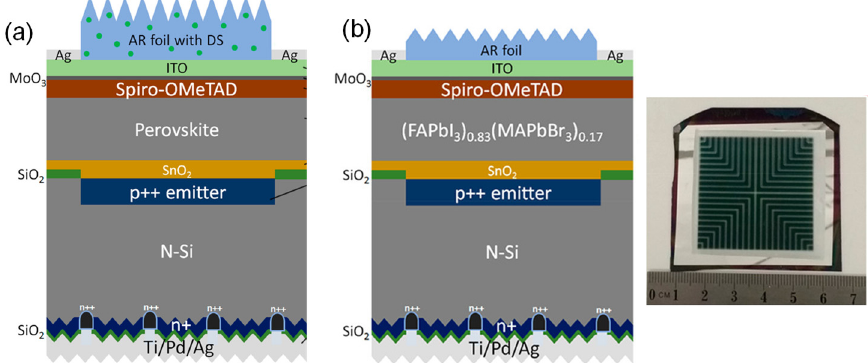
Figure 8. ( a ) Schematic of perovskite–silicon tandem homojunction photovoltaic with downshifting AR PDMS layer. From Ref. [149]. Copyright 2019 ACS Energy Letters. ( b ) Schematic of monolithic (FAPbI 3 ) 0.83 (MAPbBr 3 ) 0.17 perovskite/rear-textured-homo-junction-silicon tandem photovoltaics. Reproduced with permission from Ref. [148]. Copyright 2018 ACS Energy Letters.